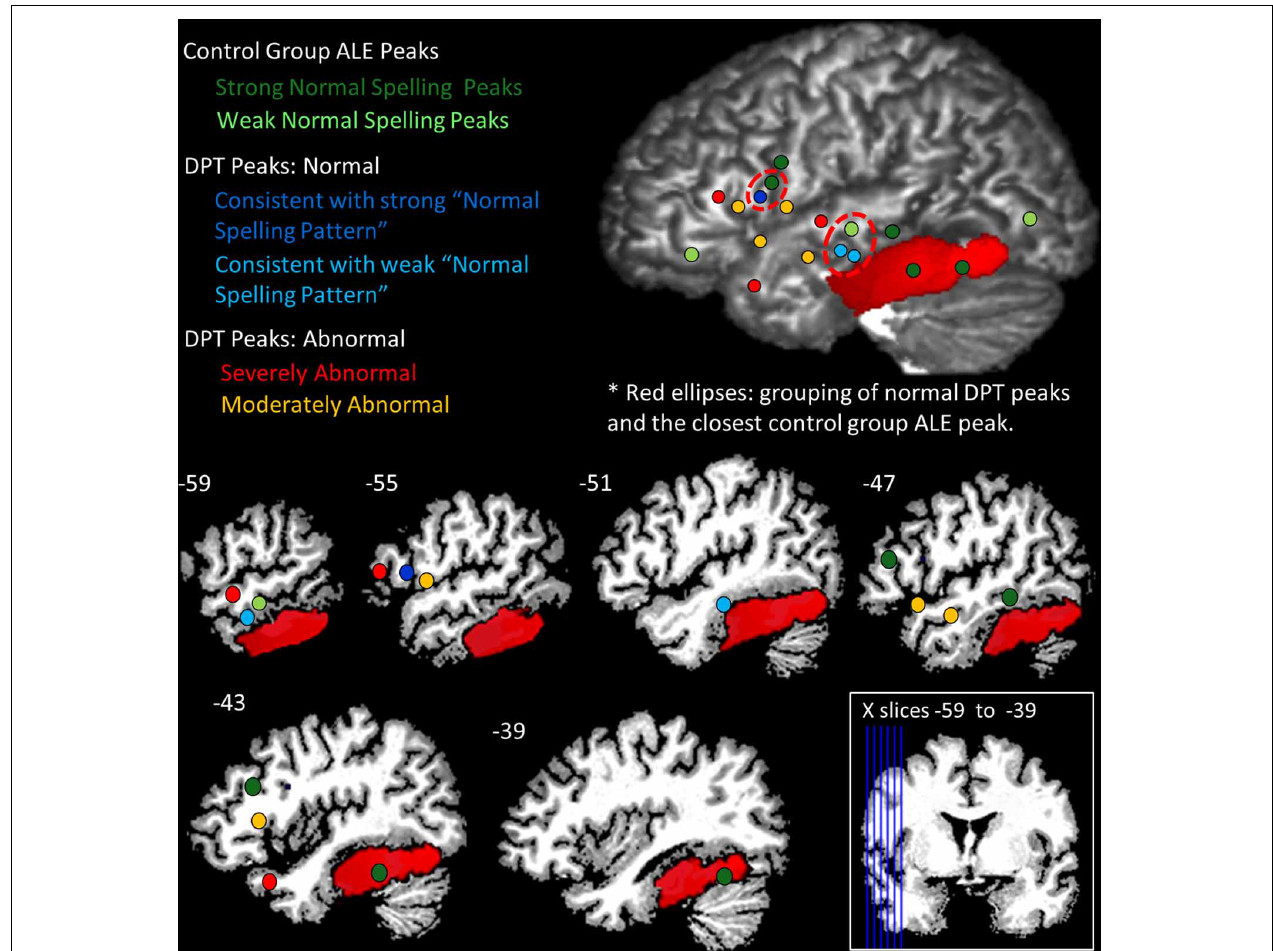
FIGURE 7 | Summary of IPPC Analysis results. Each of DPT’s peaks and the control group ALE peaks (see Table 5 ) were projected onto DPT’s brain; the red region depicts DPT’s lesion. Dots are used to visualize the peak locations and were projected at a depth of 16mm. Green identifies the location of peaks for the normal group, with dark green depicting “strong” normal activation peaks (the majority of control participants) and light green depicting “weak” normal activation peaks (see text for details). Blue dots are used to depict DPT’s activation peaks that were consistent with normal activation peaks: dark blue indicates DPT